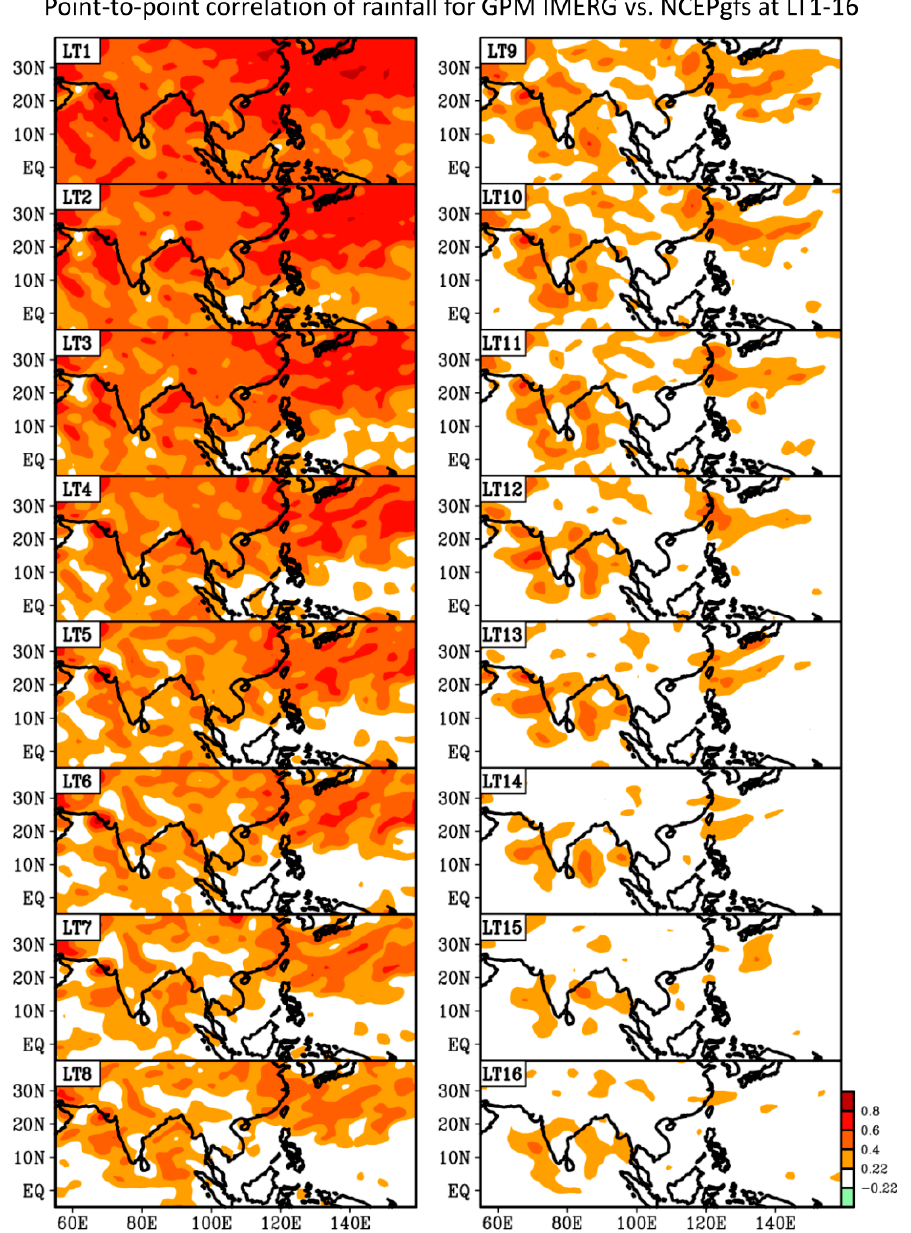
Figure 12. The horizontal distribution of point-to-point temporal correlation between the observed daily rainfall from GPM IMERG and the forecasted daily rainfall from NCEPgfs at lead times of 1 day to 16 days (i.e., LT1~16). The correlation period is during the 2017 Meiyu season. Only the areas with correlation significance at the 90% confidence interval are shaded.